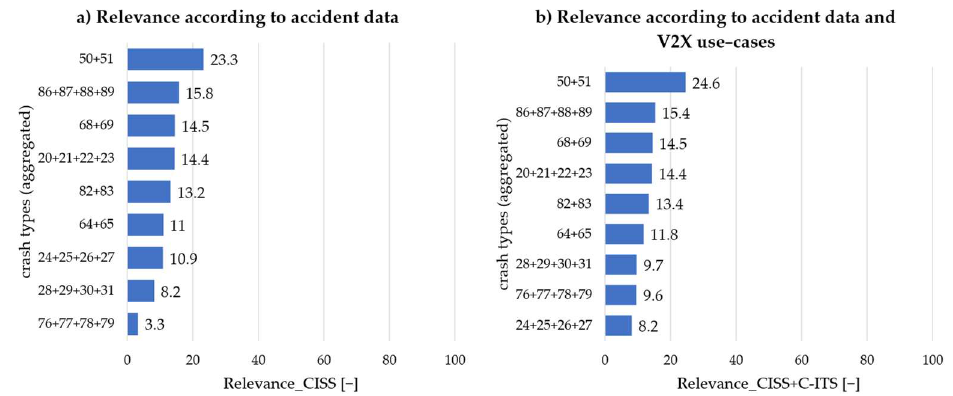
Figure 7. Sorting of the aggregated crash types according to importance (0 to 100): ( a ) without taking V2X into account; ( b ) with taking uses-cases of V2V only (approach 1) into account.